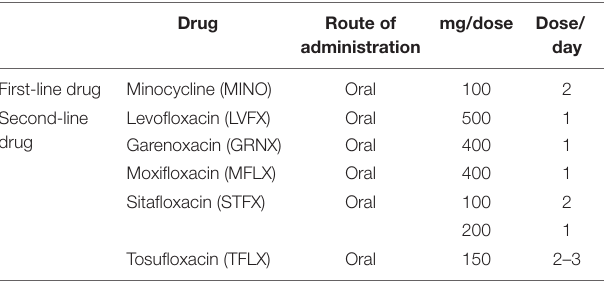
The table is adapted from the guiding principle of JSM (http://square.umin.ac.jp/